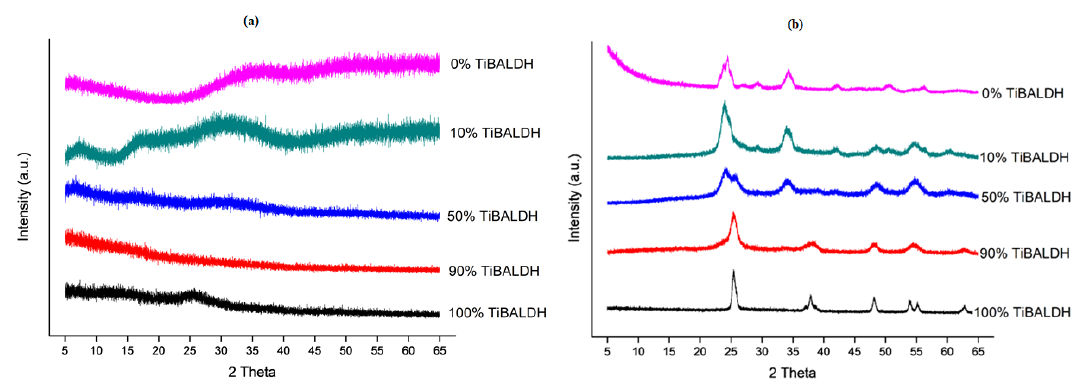
Figure 5. XRD patterns: ( a ) as spun fibers, and ( b ) as annealed fibers.